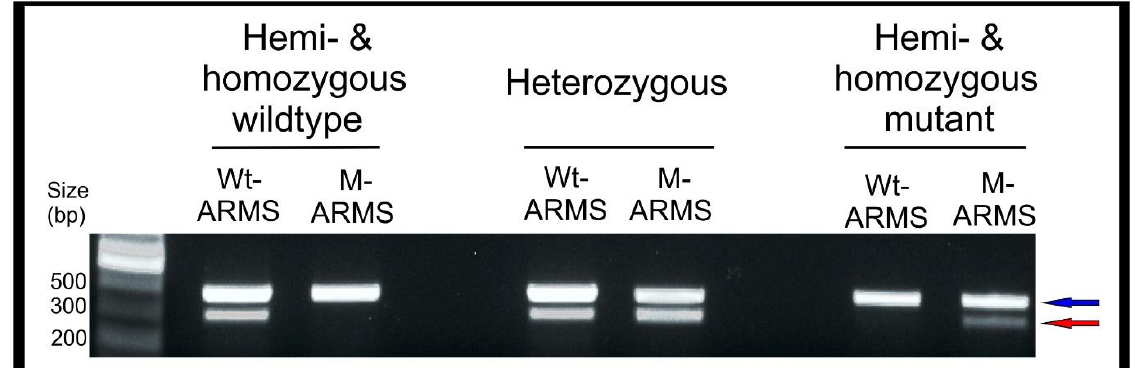
Figure 9. ARMS-PCR screening showing the banding patterns for hemi- and homozygous wildtype ( left ), a heterozygous ( middle ) and hemi- and homozygous mutant ( right ) samples. Arrows indicate the internal cyc control ( blue ) and the per amplicon ( red ).